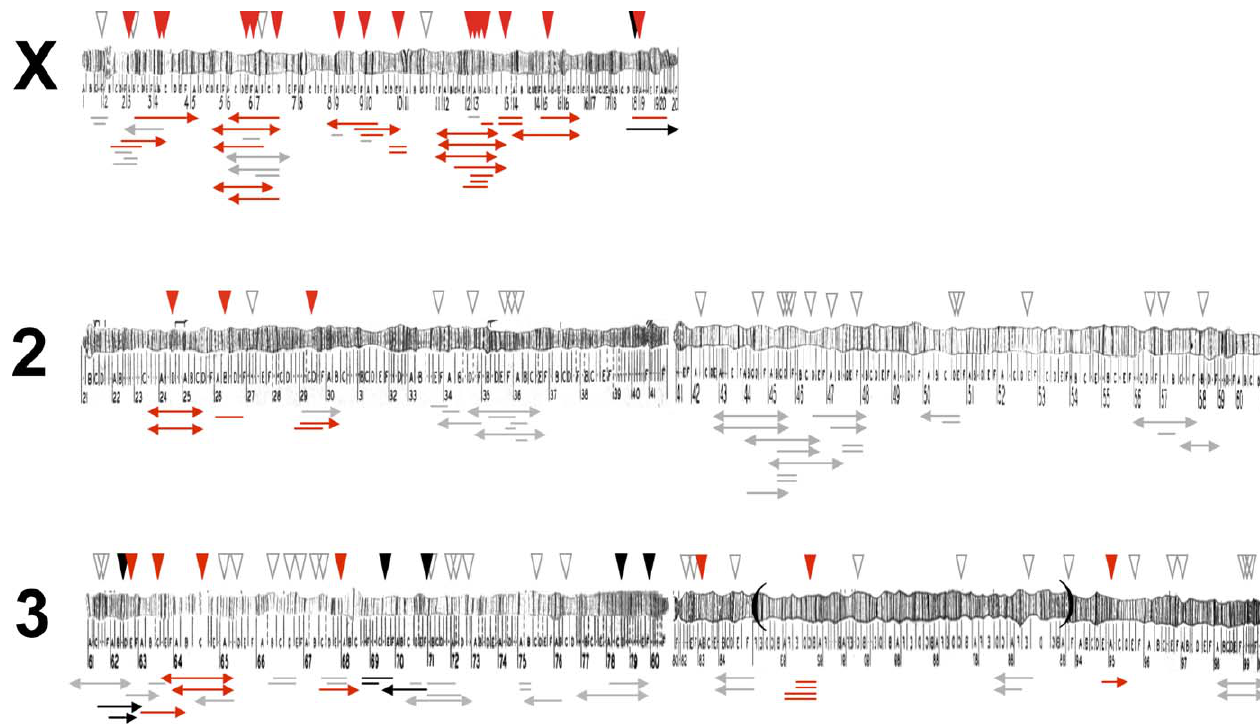
Figure 2. Distribution of D. mauritiana Introgressions in the D. sechellia Genome Inverted triangles above each chromosome show P [ w þ ] insertion sites: black indicates hybrid inviable; red indicates hybrid male-sterile; white indicates hybrid fertile or untested. Horizontal lines below each chromosome show the approximate sizes of 108 of 142 introgressions. Arrows indicate that D. mauritiana material extends beyond the marker resolution at that location. Black indicates hybrid inviable introgressions; red indicates hybrid male- sterile introgressions; gray indicates hybrid fertile introgressions. The breakpoints of an inversion difference on chromosome arm 3R between D. melanogaster and the D. simulans clade species (D. simulans, D. mauritiana, and D. sechellia) are shown as brackets.